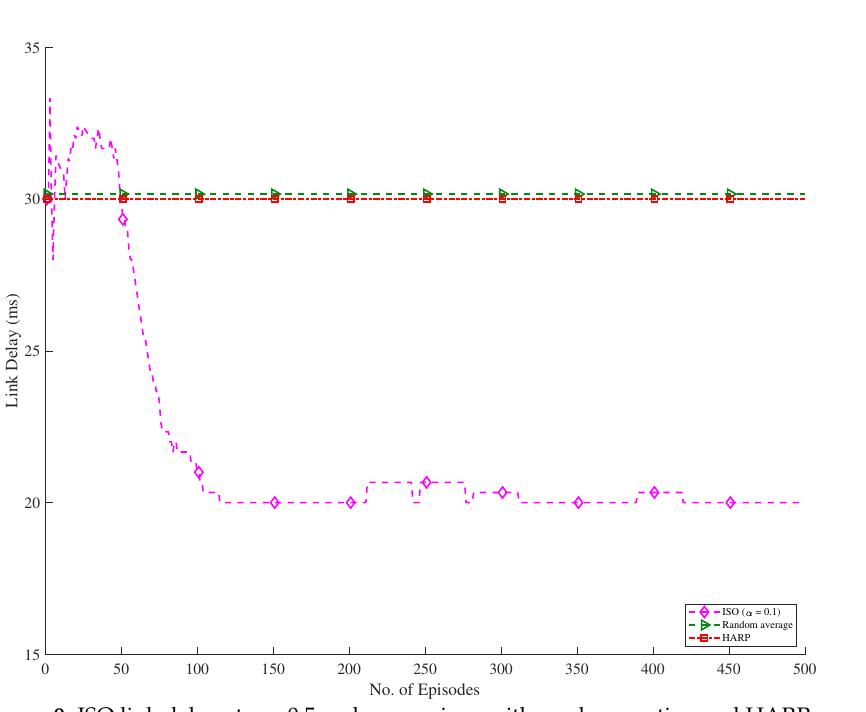
Figure 9. ISO link delay at γ = 0.5 and comparison with random routing and